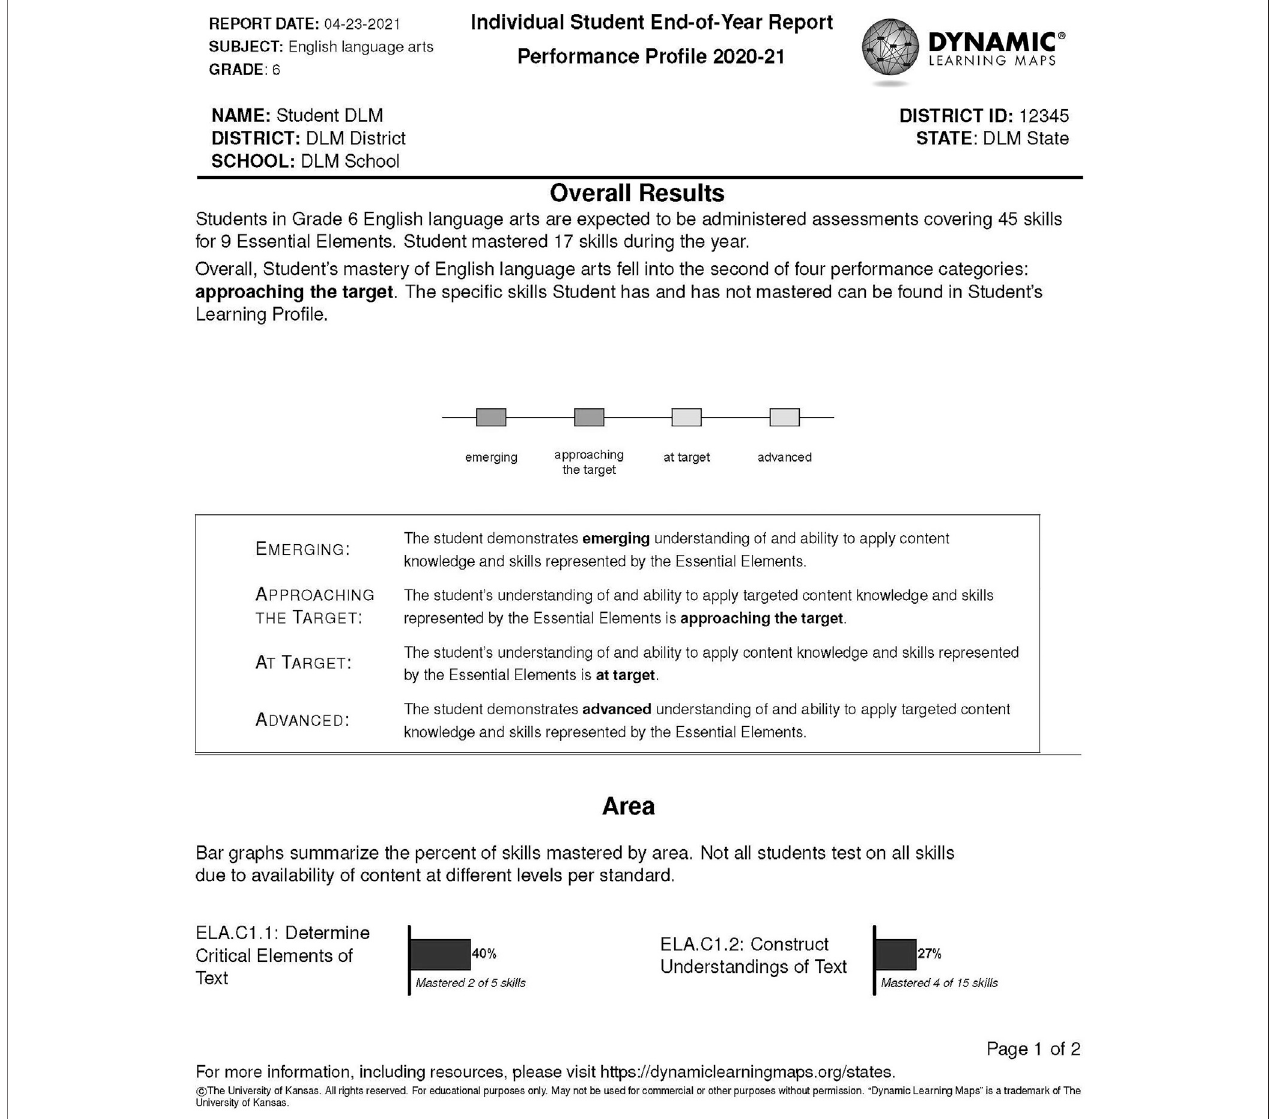
FIGURE 3 | Performance Pro fi le portion of individual student score